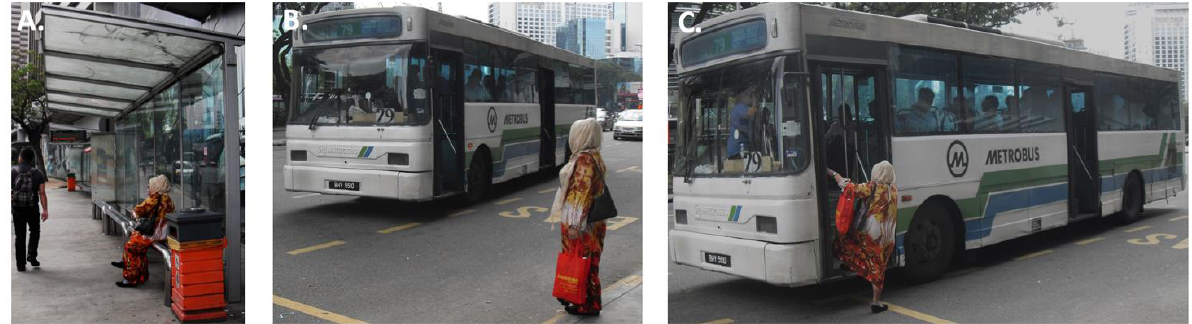
Figure 2. User observation conducted in KL, Malaysia.